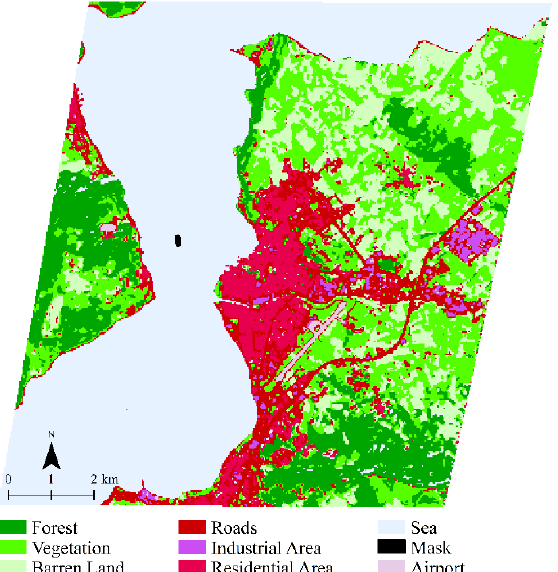
Table 4. The error matrix of the classification result that was obtained by using PRISMA satellite image (V: Vegetation, A: Figure 4. The LU/LC map that was produced by applying SVM Airport, F: Forest, S: Sea, I.A.: Industrial Area, R: Road, R. A.: to PRISMA satellite image. Residential Area, B. L.: Barren Land). In the visual analysis (Figure 5), Google Earth images (Figure 5.a, 5.d, 5.g) were used as reference data. It was observed that the airport was discriminated more accurately in the classification result (Figure 5.b), which was retrieved from the PRISMA satellite image, than the classification result (Figure 5.c) which was retrieved from the Landsat-9 satellite image. Similarly, industrial area was distinguished more accurately by using PRISMA image (Figure 5.h), (Figure 5.i). On the other hand, roads were classified more accurately with Landsat-9 satellite image as shown in Figure 5.f, compared to PRISMA classification result that is shown in Figure